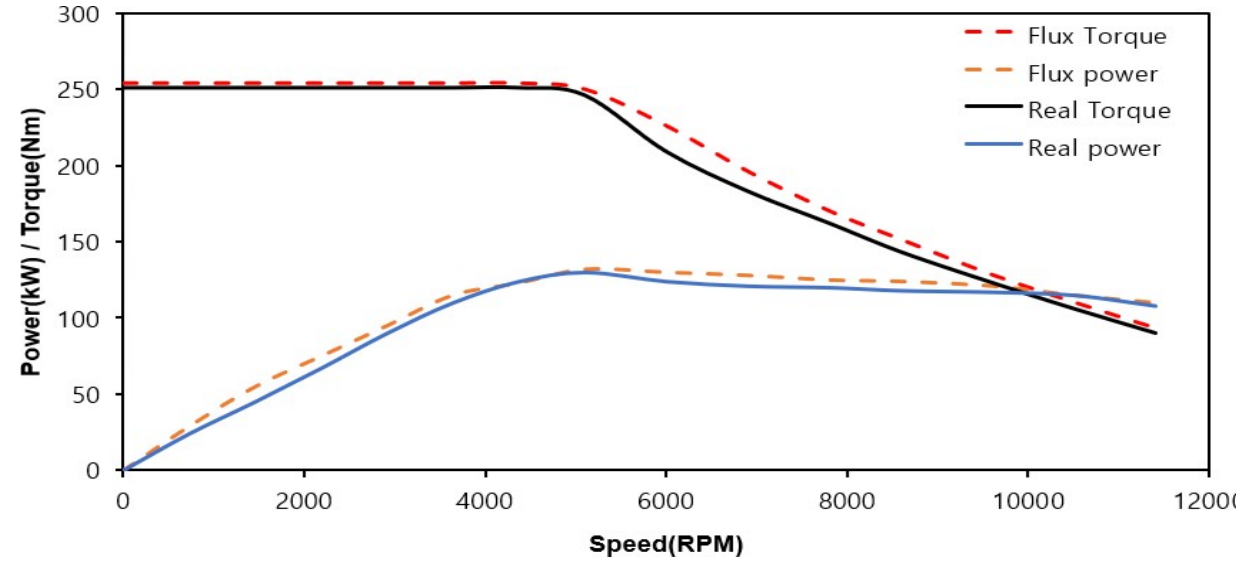
Figure 4. Comparison of motor torque–output.